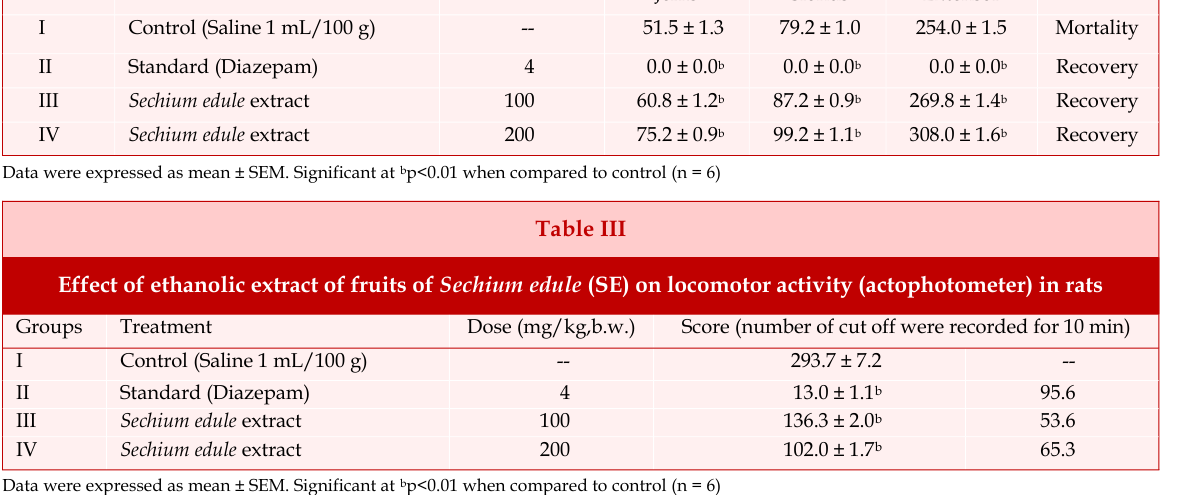
Effect of ethanol extract of fruits of Sechium edule on rota rod test in rats